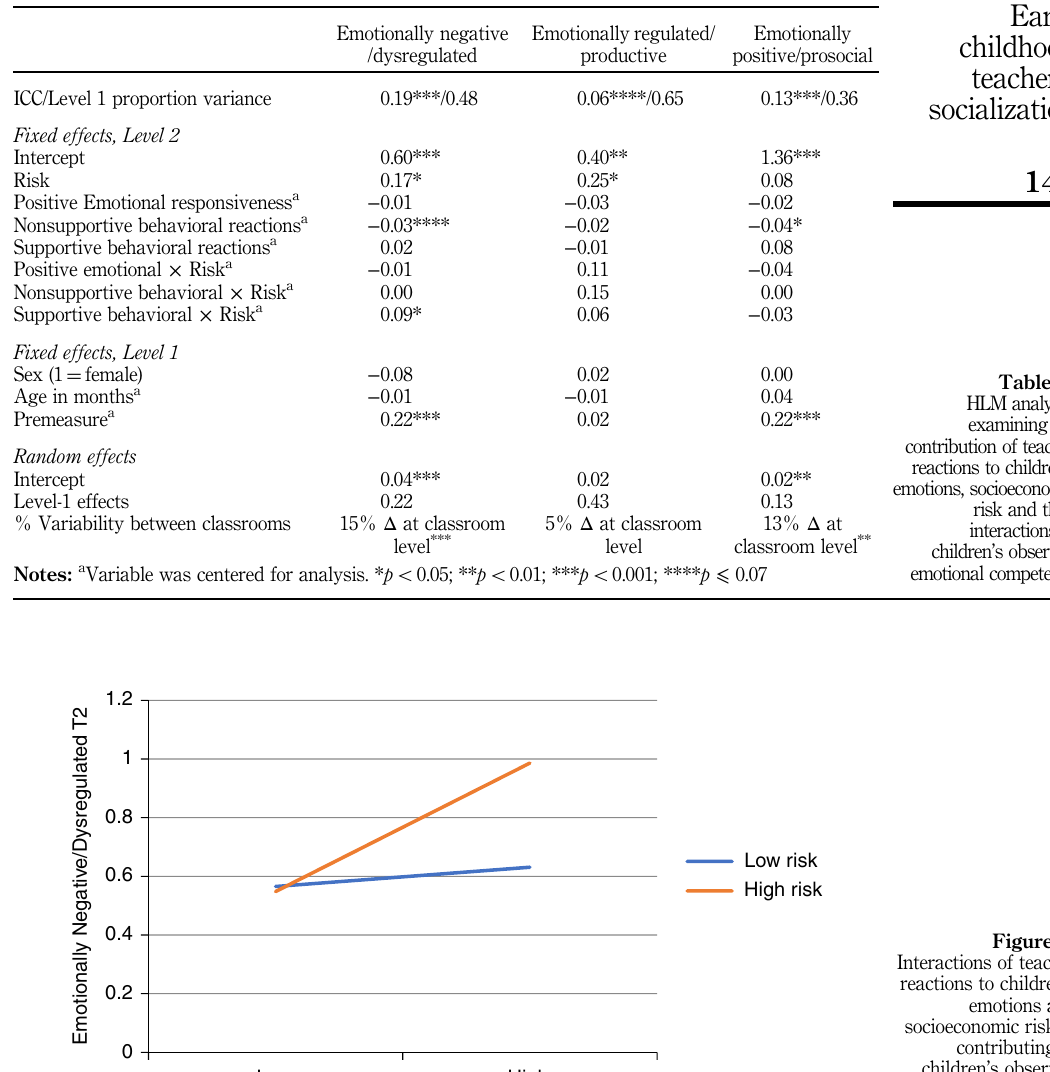
Figure 2. Interactions of teacher reactions to children ’ s emotions